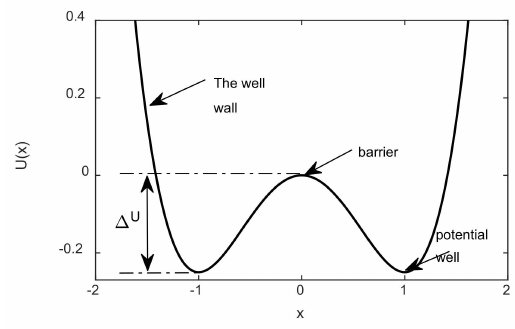
Figure 1. Potential function diagram of classical bistable